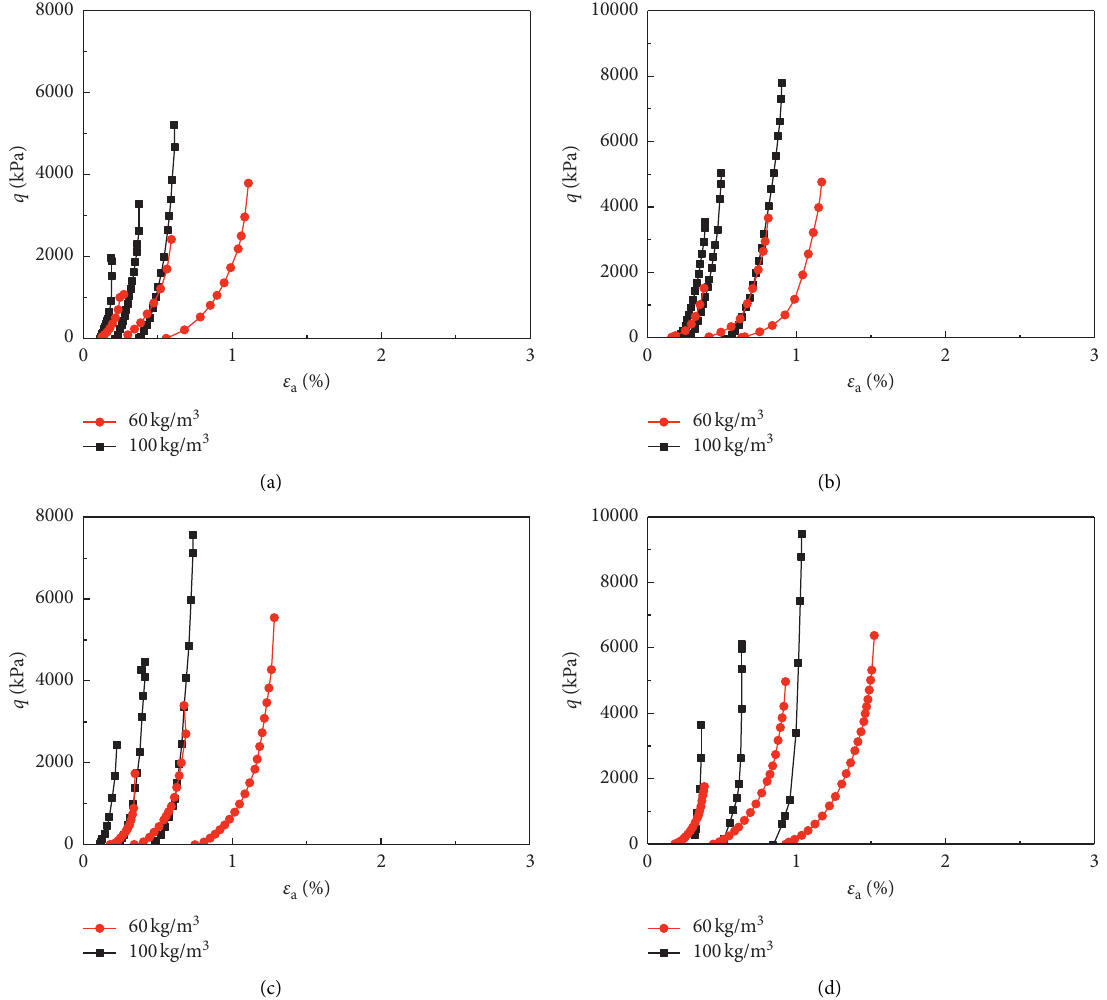
Figure 7: LCSG material unloading curves for different confining pressures. (a) 300kPa. (b) 600 kPa. (c) 900kPa. (d)